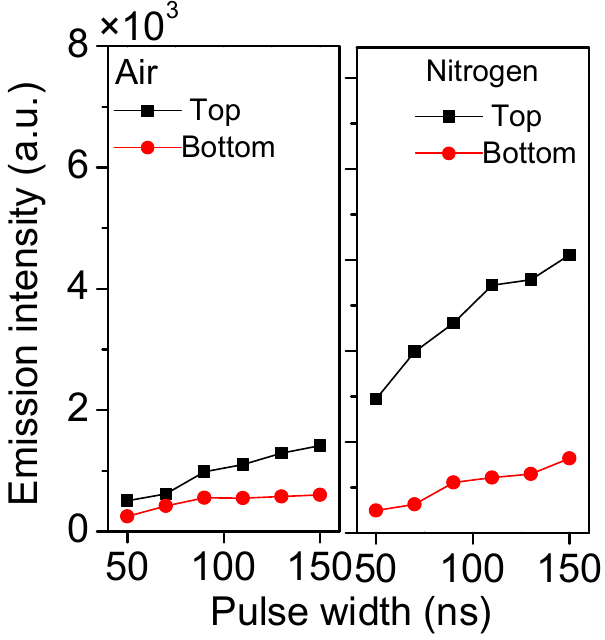
Figure 10. Effects of pulse duration on the emission intensity of FNS of N 2+ collected from the top and bottom of the reactor under air and nitrogen.